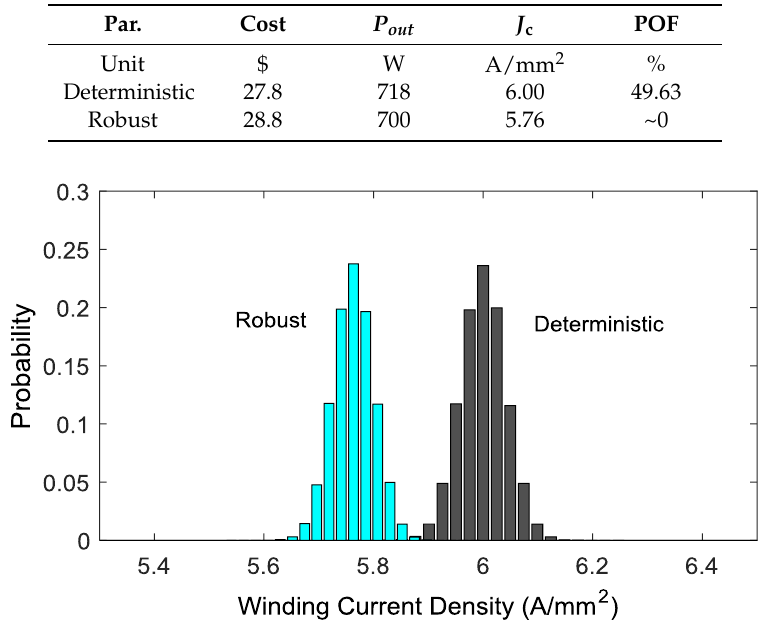
Table 8. Main dimensions and parameters for the TFM.